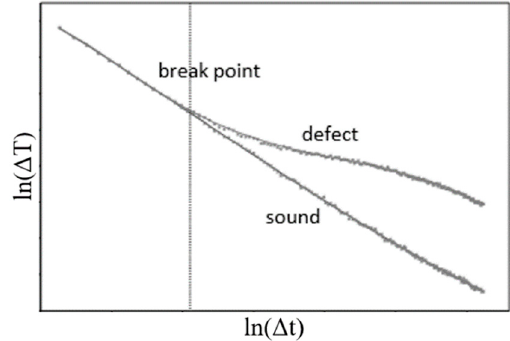
Figure 2. Trend of cooling curve in a double logarithmic scale.